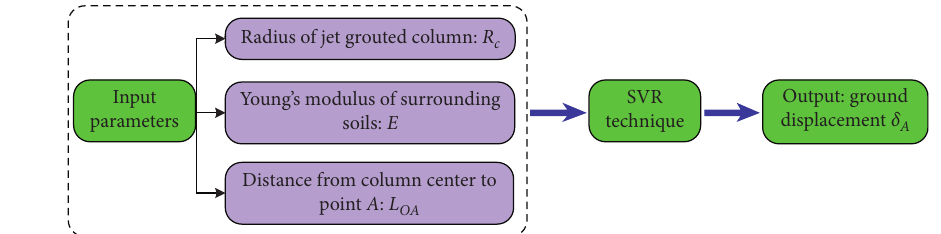
Figure 4: Prediction structure of the SVR technique in this study.